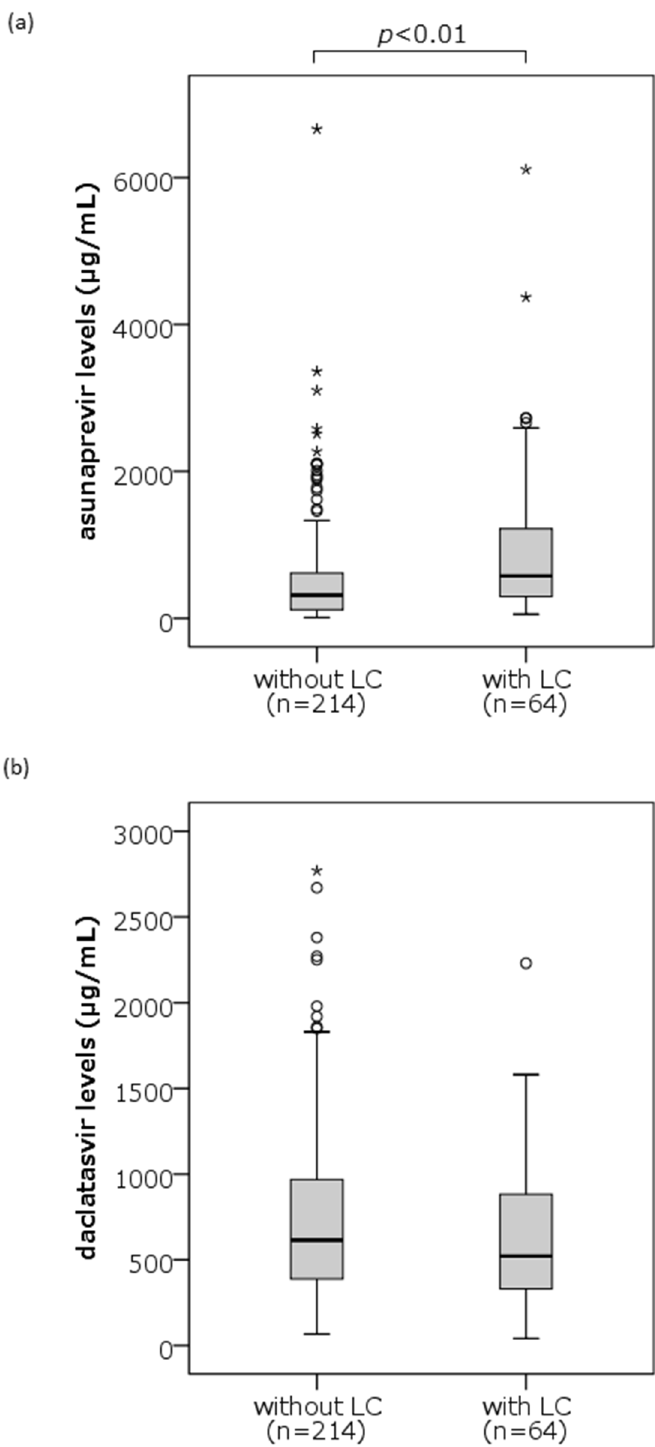
Fig 3. Comparison of serum asunaprevir (ASV) and daclatasvir (DCV) concentrations between patients with liver cirrhosis (LC) and those without LC. Serum ASV concentrations were significantly higher in patients with LC than in those without LC (579; 56–6,110 ng/mL vs. 315; 11–6,660 ng/mL, p < 0.001), but no such difference was observed for the serum DCV concentrations. In these box-and-whisker plots, lines within the boxes represent the median values; the upper and lower lines of the boxes represent the 25th and 75th percentiles, respectively. The tails indicate the